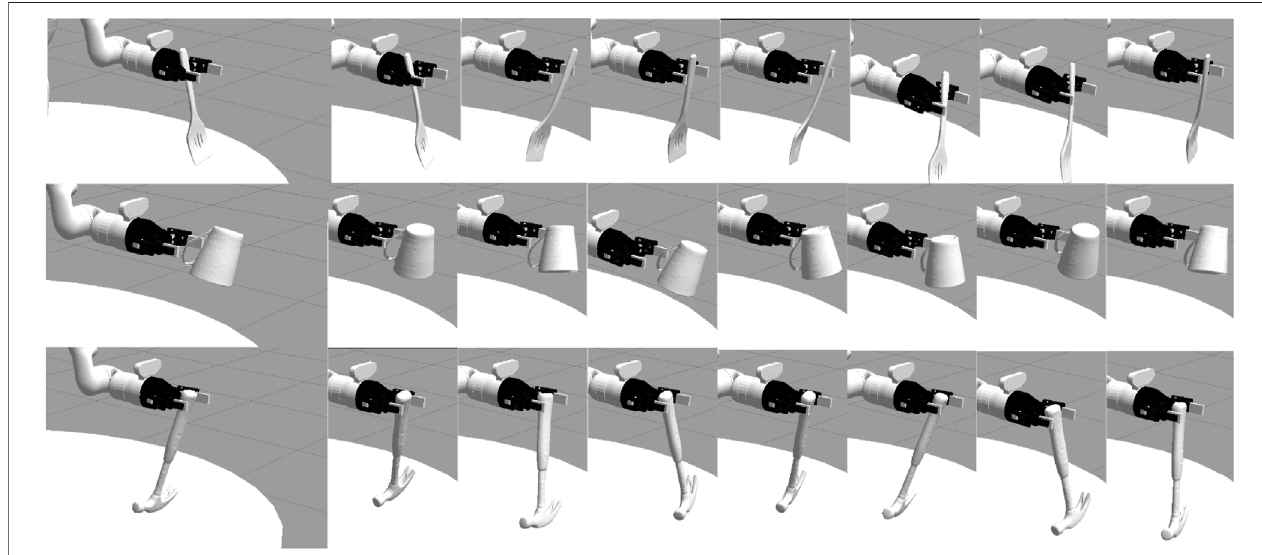
FIGURE 2 | We performed an evaluation across three tools: a spatula, mug, and hammer. For each tool, we perturbed the trajectory of the tooltip by adjusting the robot ’ s grasp of the tool. These pose variations are just a small set of the 729 perturbations we evaluated for each tool-task pairing.